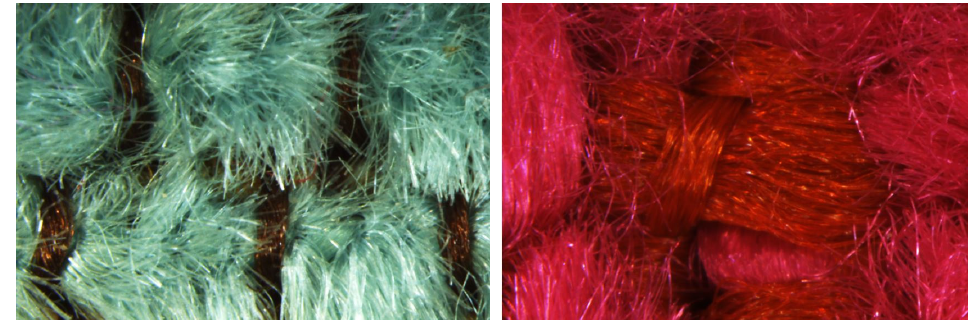
Figure 2. Surface and the warp / weft pathways of the textile materials is analyzed with microscope imaging technique with 16X magnifications. left : T1; right : T2. imaging technique with 16X magnifications. left : T1; right : imaging technique with 16X magnifications. left : T1; right : T2.